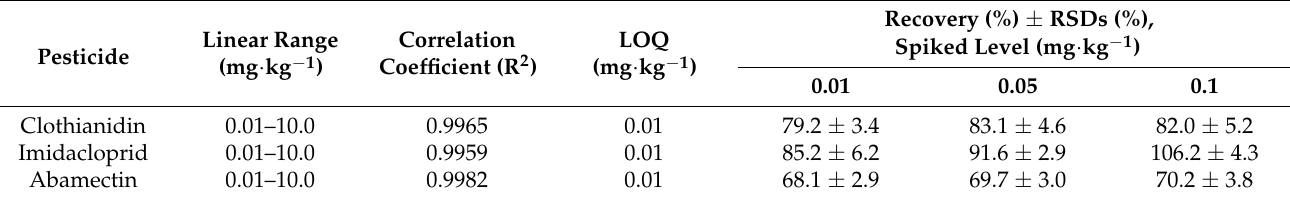
Table 3. Method validation of pesticides in a soil